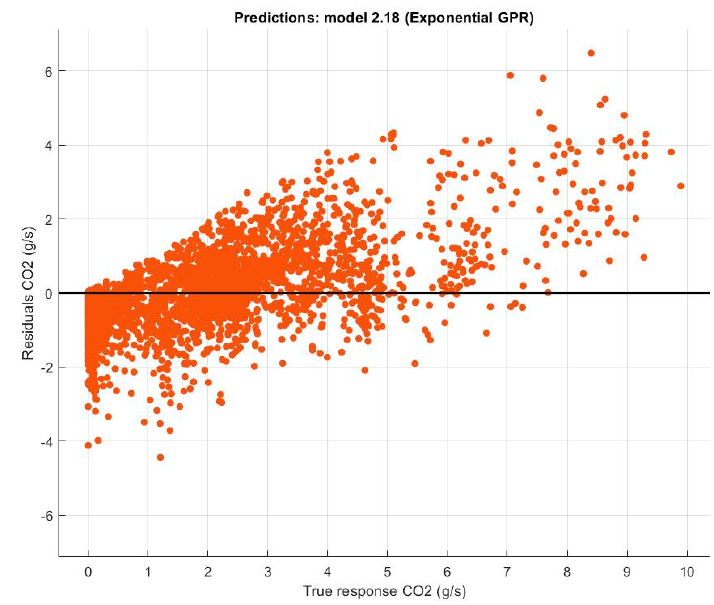
Figure 8. Residuals vs. predicted response scatter plot for the CO 2 emissions.